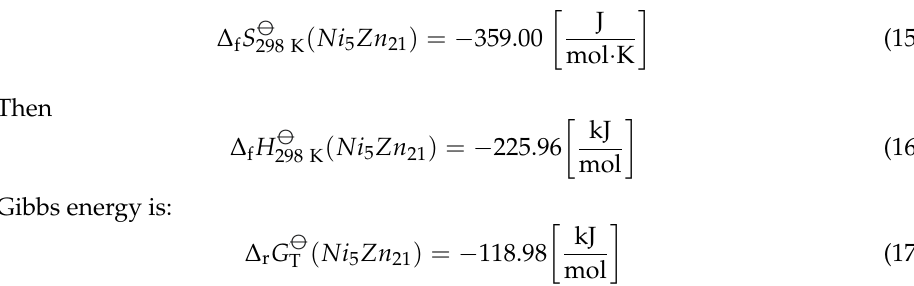
Table 14. Calculated enthalpy of formation of some Ni-containing substances.